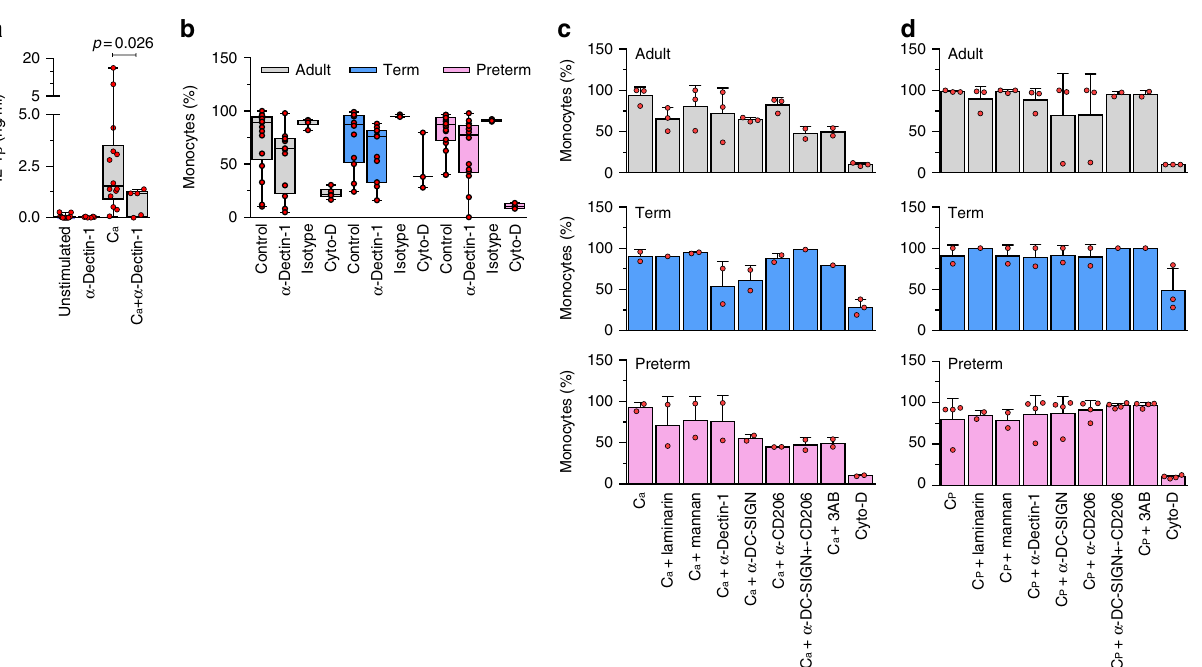
Fig. 2 Importance of dectin-1 in response to Candida in neonatal monocytes. a Antibody blocking of dectin-1 reduces cytokine production to C. albicans (C a ) in adult mononuclear cells (one-sided t -test with Welch ’ s correction for unequal variance; 6 to 12 subjects per condition; boxes and whiskers); b Phagocytosis of C. albicans upon blocking with anti-dectin-1 receptor antibody, same-isotype control or cytochalasin-D (Cyto-D); (11 to 18 subjects per age group; boxes and whiskers); Blocking of c C. albicans (C a ) or d C. parapsilosis (C p ) phagocytosis using laminarin (blocking dectin-1), mannan (blocking dectin-2 and mannose receptor), anti-DC-SIGN, and anti-CD206 antibodies, or a combination of all three antibodies (bar graph with mean ± standard deviation (SD); 2 to 3 subjects per age